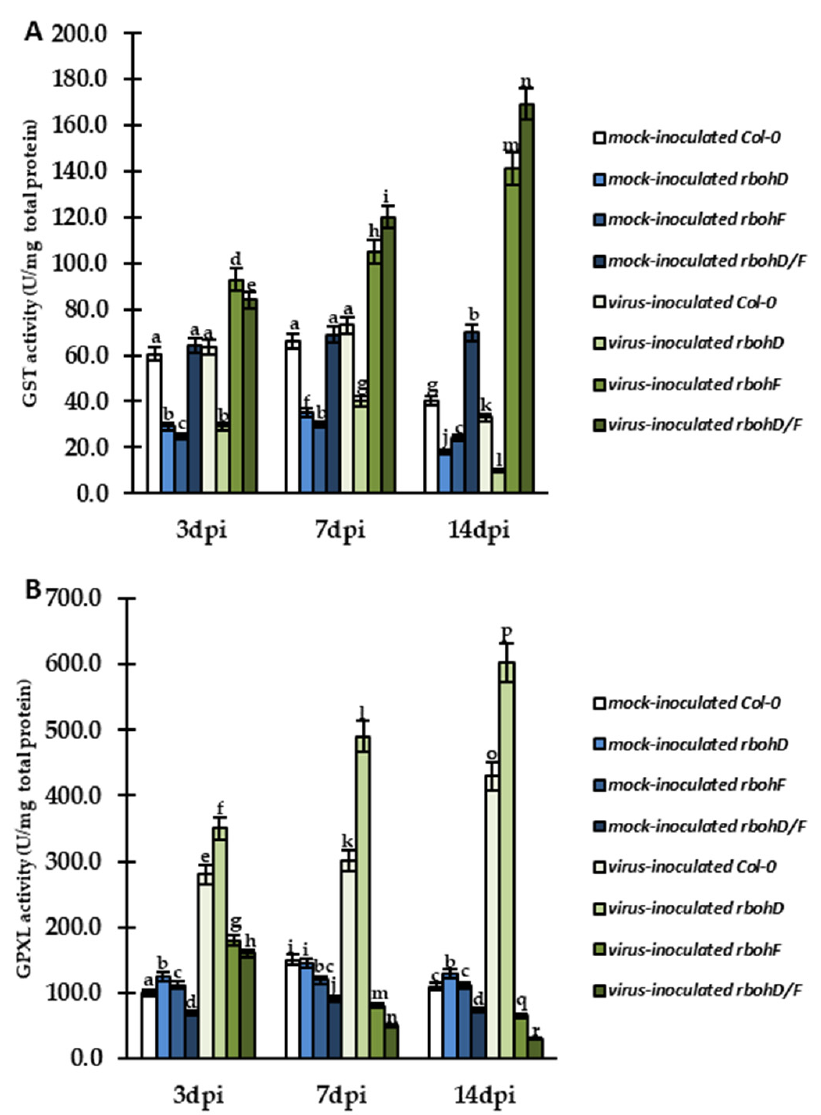
Figure 10. Activity of GST ( A ) and GPXL ( B ) in the leaves of TuMV- and mock-inoculated Col-0, rbohD , rbohF , and rbohD/F plants between 3 and 14 dpi. The mean activities (in U/mg total protein) were calculated and analyzed by ANOVA and Tukey’s HSD test at p < 0.05. Statistically significant values are indicated by different letters above the